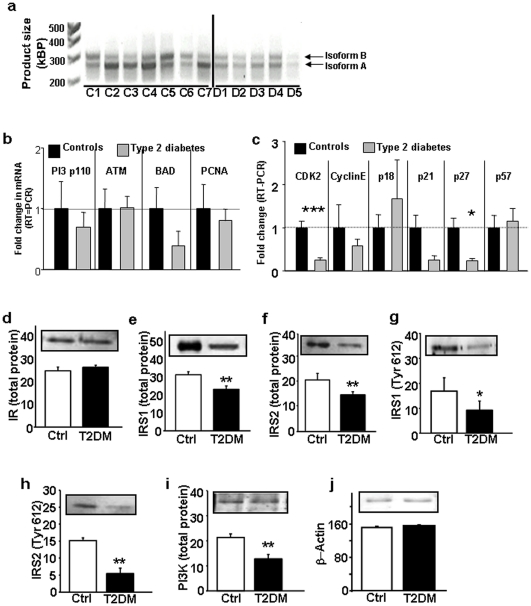
Reduced transcript levels of insulin signaling and cell-cycle proteins and protein levels of insulin signaling components in islets isolated from patients with T2DM.(a) Expression of insulin receptor isoforms A and B; (b) transcript levels of insulin signaling proteins, and (c) transcript levels of cell-cycle proteins. Data are expressed after normalization for TATA binding protein (TBP) (n = 5–7); *, p<0.05; ***, p<0.001; controls vs T2DM. (d) protein expression of total insulin receptors, (e), total insulin receptor substrate-1, (f) total insulin receptor substrate-2, (g), tyrosine-612 IRS-1, (h) tyrosine-612 IRS-2, (i) or total phosphatidyl inositol 3-kinase. *,p<0.05; **,p<0.001 Control vs T2D. Data in 2d–i are immunoprecipitates. (j) β-actin was used to normalize the data in Figures 2d–i.